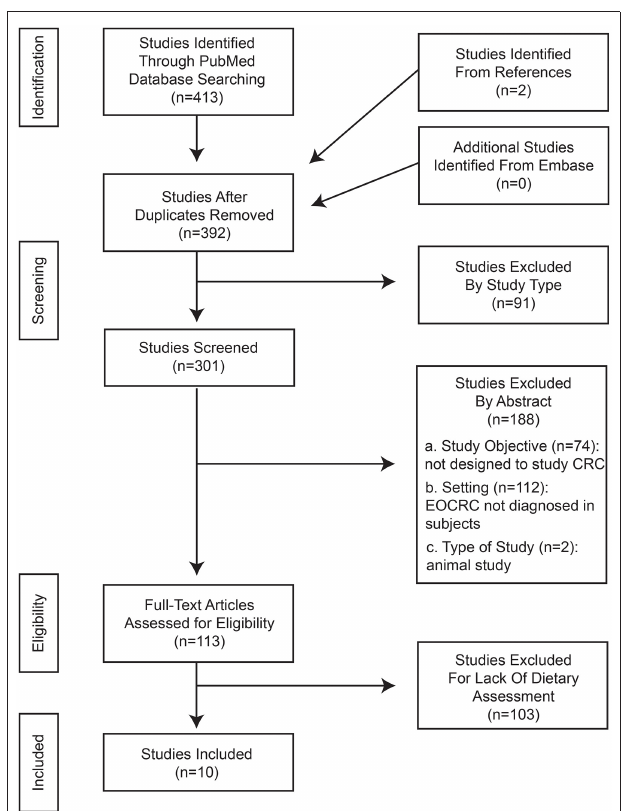
FIGURE 1 | PRISMA flow